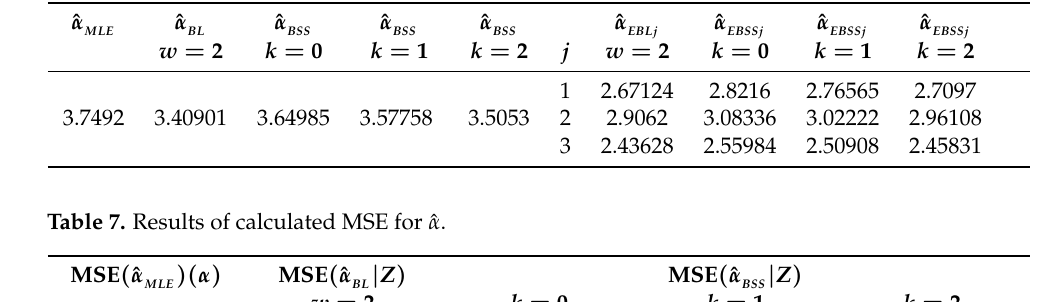
Table 6. Estimations of α , with s = 10, β = 3.0, u = 3 and v = 4.